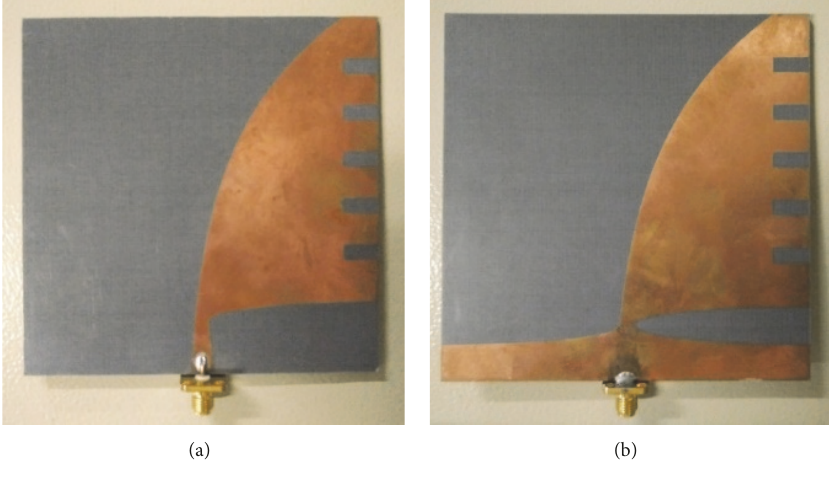
Figure 9: Photograph of the fabricated antenna.